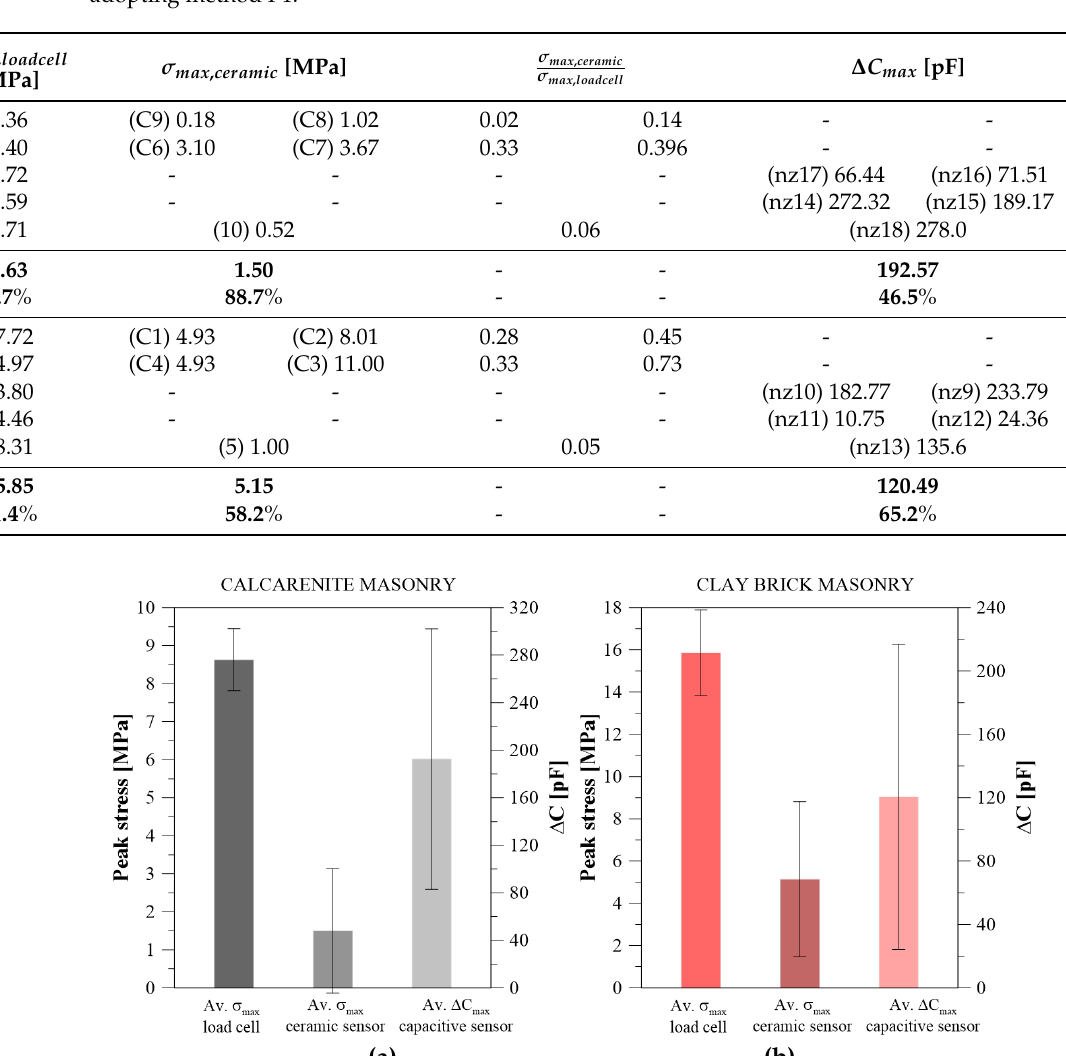
Table 3. Peak stress values recorded by the load cell of the testing machine and ceramic stress sensors and capacitance variation values at the peak recorded by the capacitive stress sensors post-installed adopting method P1.